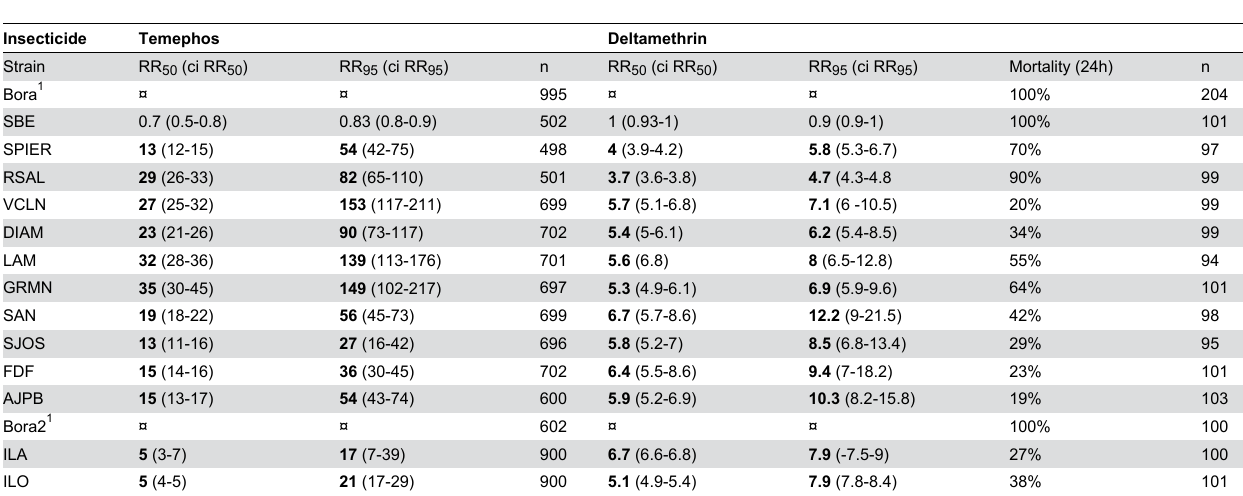
Table 1. Resistance status of Aedes aegypti populations of Martinique to temephos (larvae) and deltamethrin (adults).